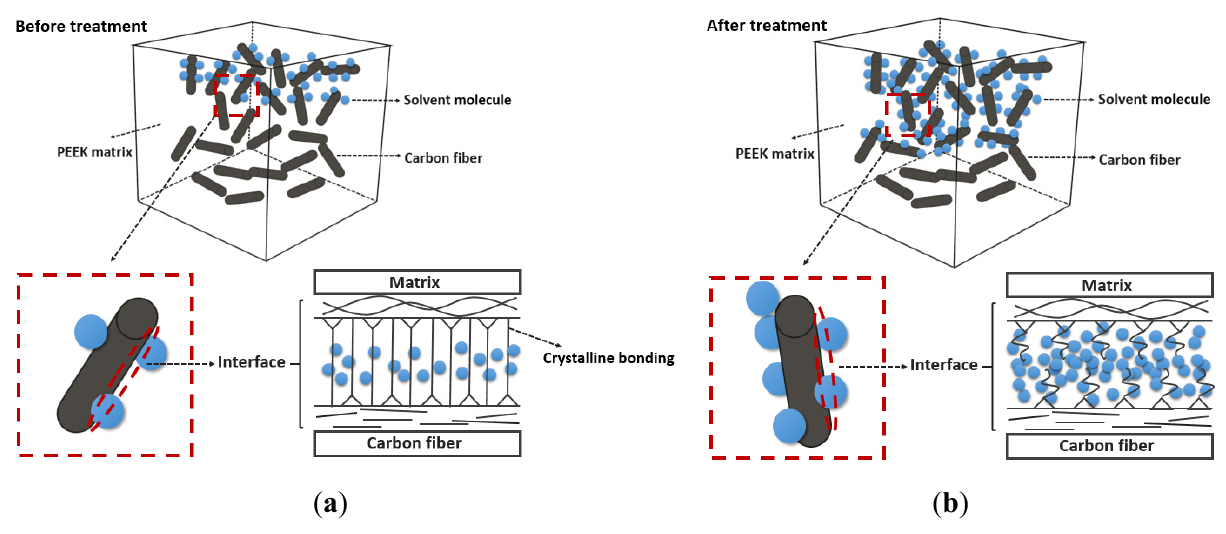
Figure 8. Schematic of solvent molecules penetrating ways of the CFR-PEEK